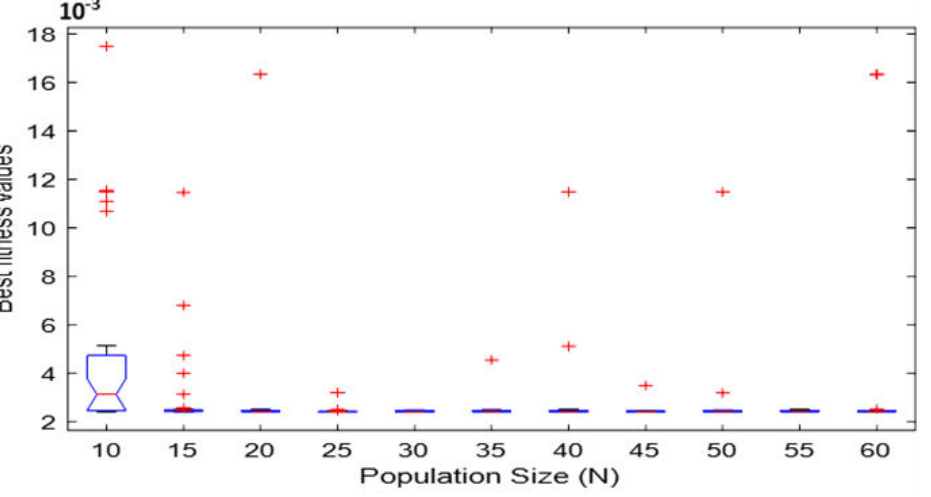
Figure 4. Sensitivity analysis of parameter